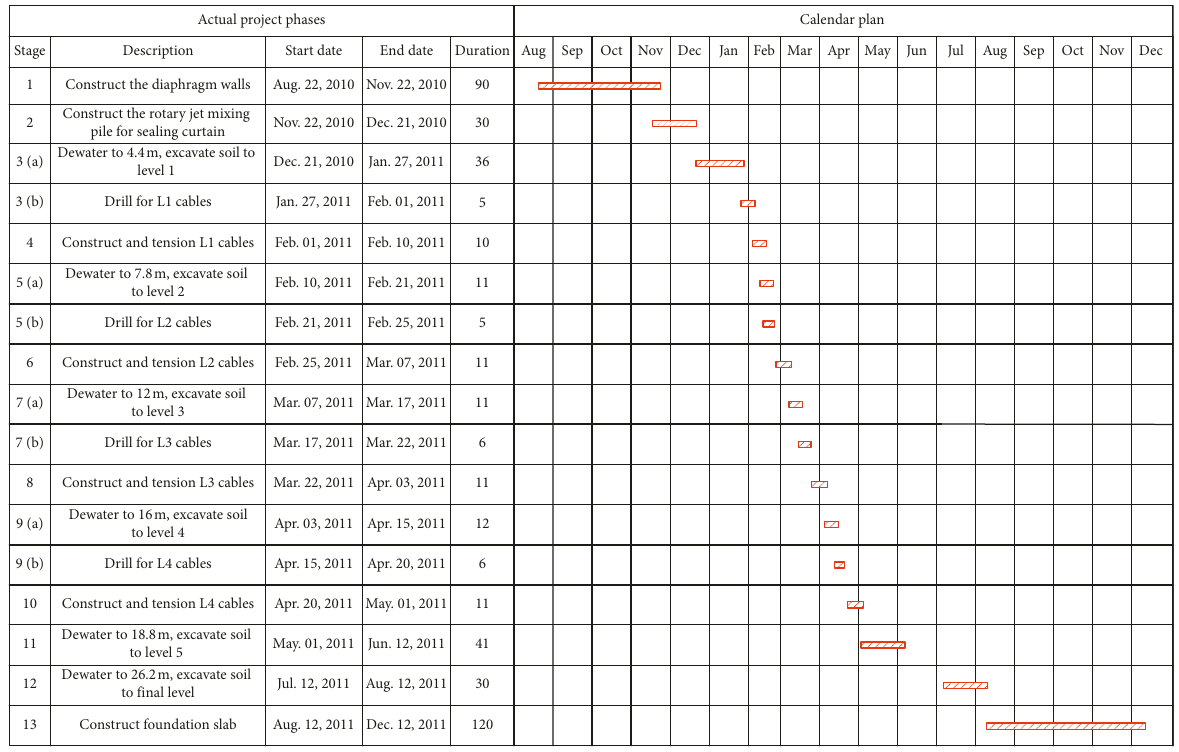
Figure 7: Schedule of construction procedure.